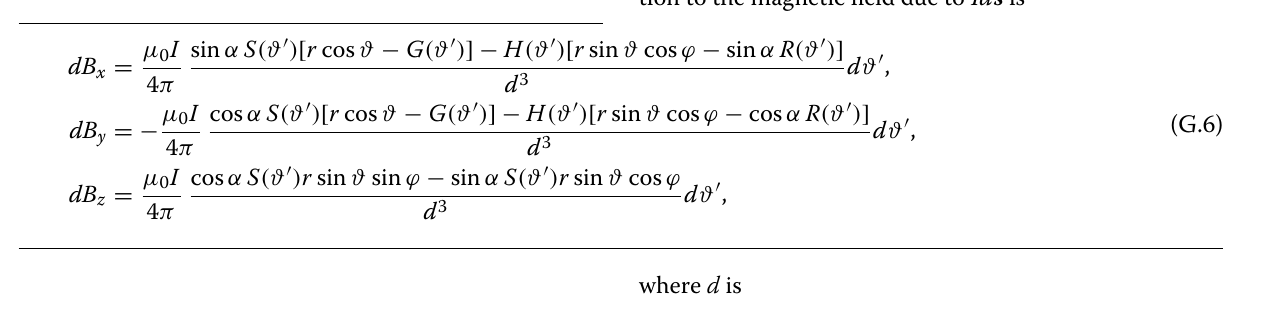
Substituting the last two equations and Eq. (B.5) into Eq. (A.1), the Biot–Savart law for an infinitesimal contribu- tion to the magnetic field due to Id s is